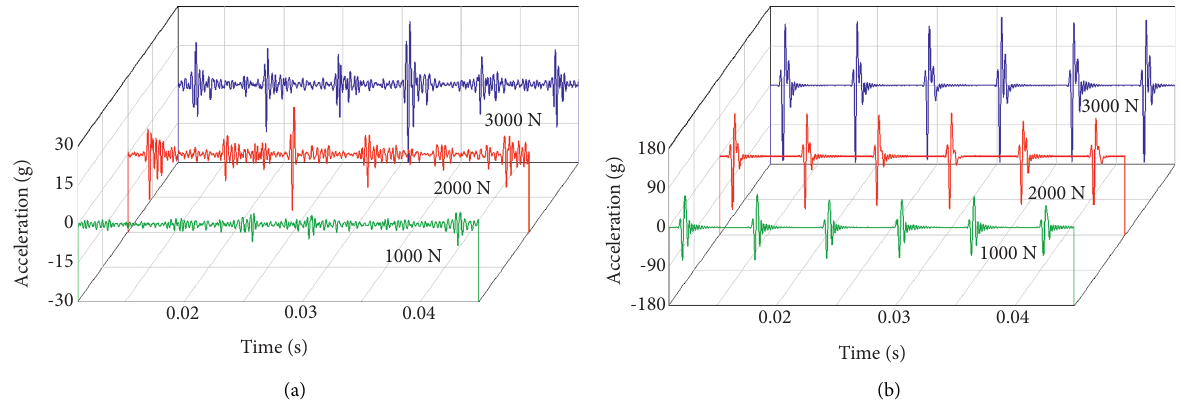
Figure 10: Acceleration signals under different loads at different points: (a) the measurement point #1 and (b) the defect point # 0.